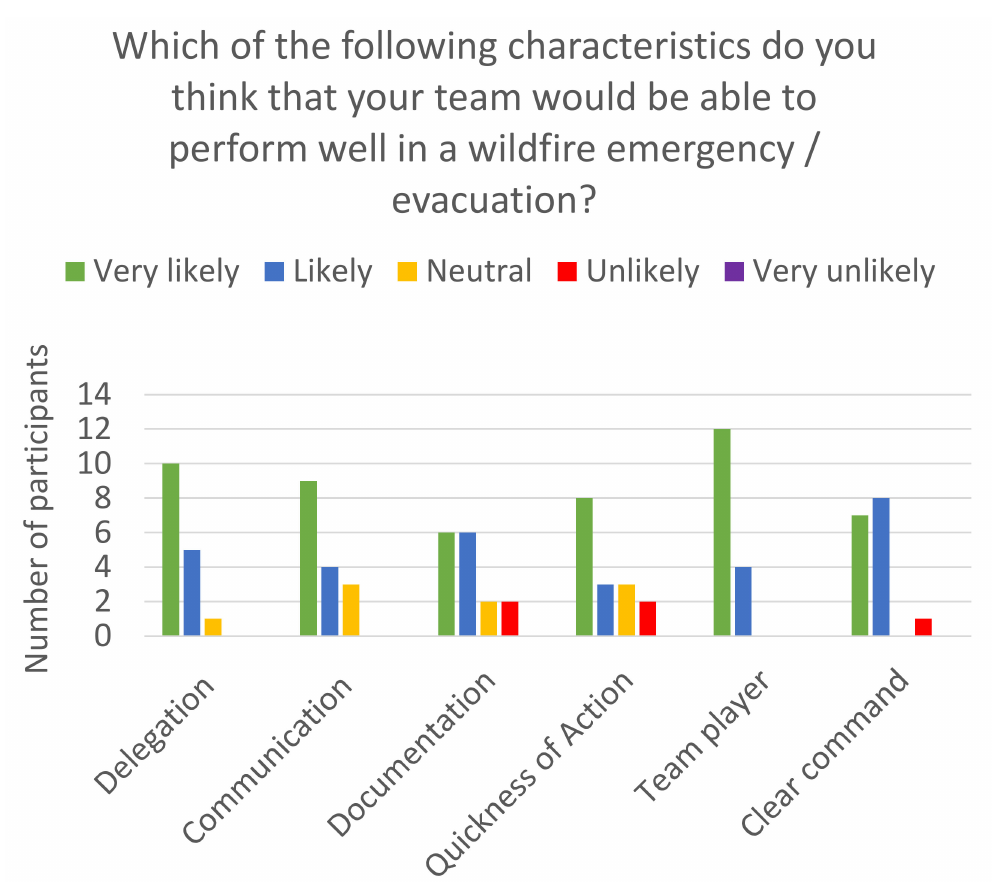
Figure 3. Projected team performance in wildfire emergency/evacuation among California, Oregon, and SW Washington NICUs. The majority of NICU medical professionals feel that their team is very likely to have good delegation, communication, quickness of action, being a team player during a wildfire